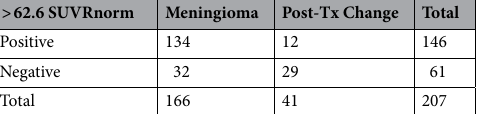
Table 6. Contingency table for the SUVRnorm method at the optimal threshold of 62.6.